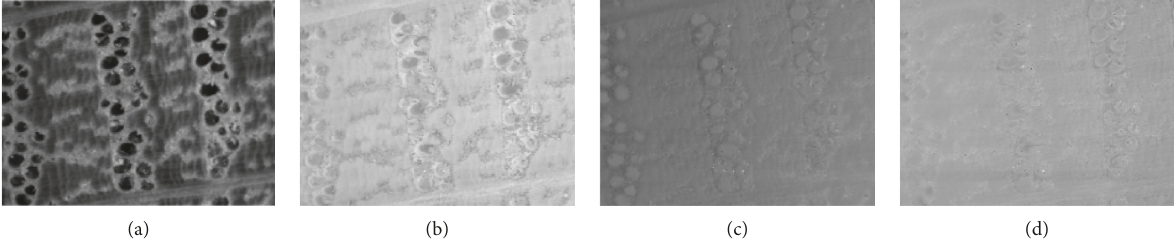
Figure 17: Schematic of image fusion with wavelet transform. (a) Band X waveband image as an example.